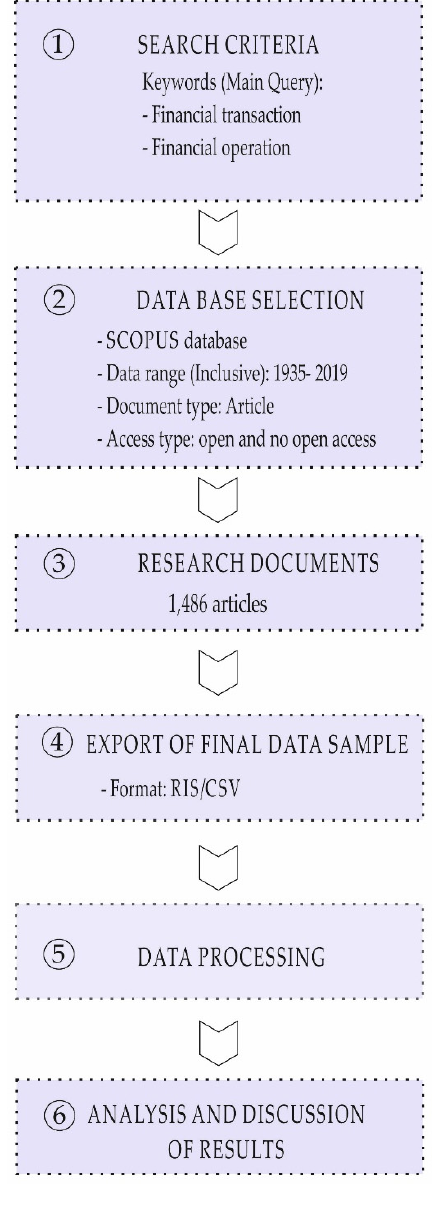
Figure 2. Flowchart of methodology applied.